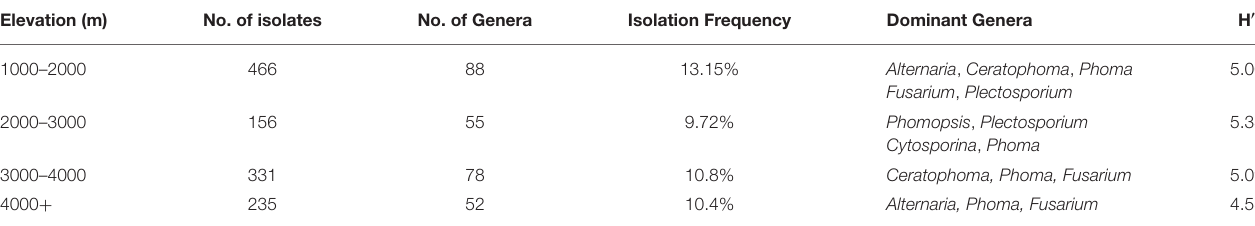
TABLE 3 | General information of fungal endophytes isolated from sites at different altitudes. Elevation (m)